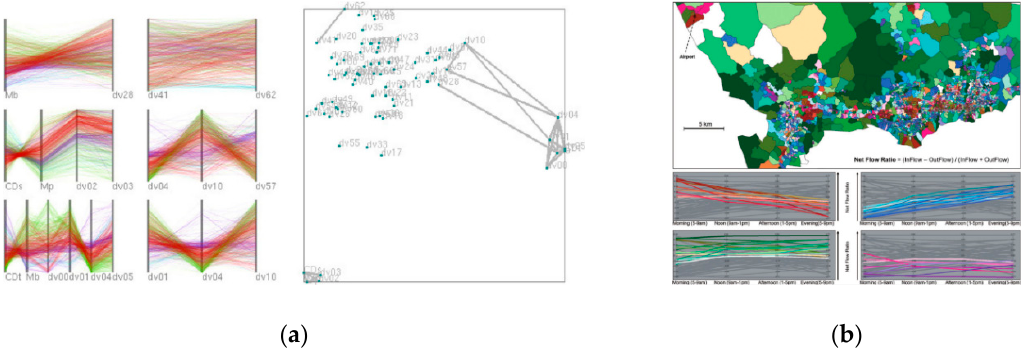
Figure 35. Parallel-coordinate visualizations: ( a ) low-dimensional PCPs and a corresponding dimension graph [89]; and ( b ) PCP views of variations in the number of taxis [90].